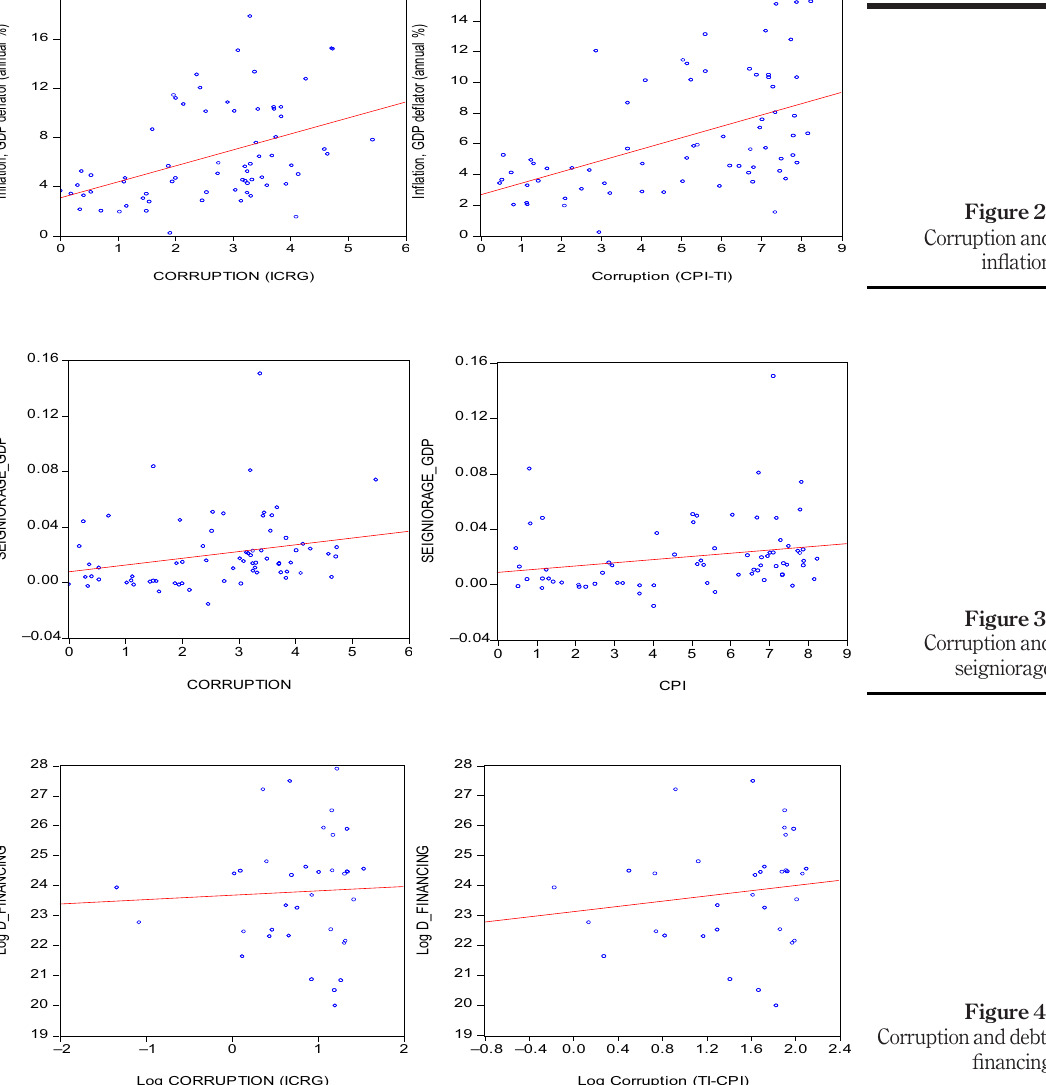
Figure 4. Corruption and debt- fi